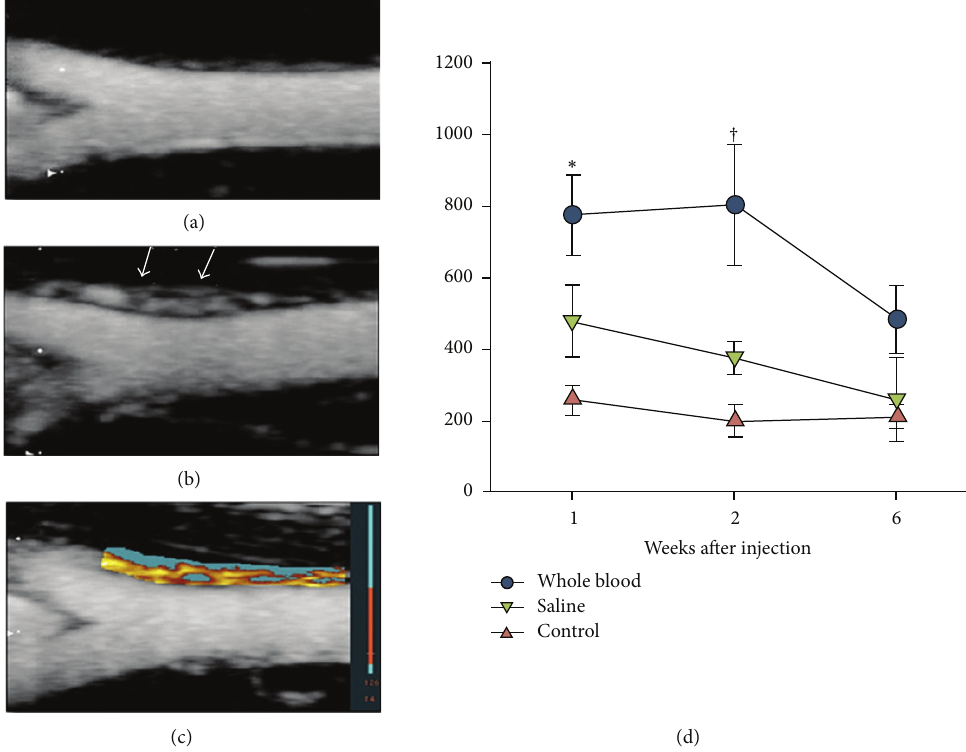
Figure 2: Vasa vasorum blood volume on contrast-enhanced ultrasound imaging. Examples of maximum intensity projection images 2s after the destructive pulse sequence are shown for femoral arteries 2 weeks after injection of either saline (a) or whole blood (b), illustrating a greatervasavasorum(VV)density(arrows)inthelatter.(c)Exampleofpixelintensitythresholdanalysisfortheblood-injectedvesselwhereby pixels within the region of interest that enhance beyond threshold intensity are displayed in red-orange color scale and those that do not are displayed in blue. (d) Mean ( ± standard error of the mean) area of enhancement on pixel intensity threshold analysis, an index of functional VV blood density. Data for contralateral noninjected control vessels were similar between treatment cohorts and are grouped. ∗ 𝑃 < 0.05 versus control contralateral artery; † 𝑃 < 0.05 versus both contralateral and saline-injected arteries (corrected for multiple comparisons). Reprint with permission from